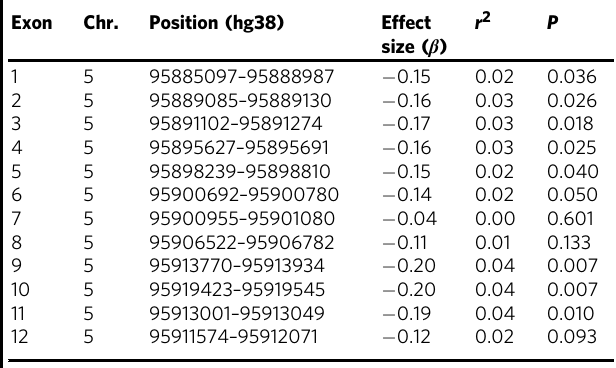
rs3815768TT 11 ELL2 P =0.007 (cid:2) =–0.2 P =5.3 e –14 (cid:2) =–0.29 Fig. 1 The ELL2 MM risk allele confers lower ELL2 expression in MM plasma cells. a Boxplot showing decreased expression of ELL2 exon 10 associated with the MM risk allele (represented by rs3815768-C) compared to the protective allele (rs3815768-T) in CD138 + bone marrow cells from 185 Swedish and Norwegian MM patients. Expression values are fragments per kilo base of exon per million fragments mapped (FPKM) obtained by mRNA sequencing. b Boxplots showing a corresponding association in Affymetrix gene expression microarray data CD138 + bone marrow cells from MM patients from Germany, United Kingdom, and the US. Boxes indicate medians and the fi rst and third quartiles. Whiskers indicate fi rst and third quartiles plus 1.5 times the interquartile range. Outliers are plotted as individual dots. Pearson correlation P values and effect size ( β ) Table 1 Association testing results